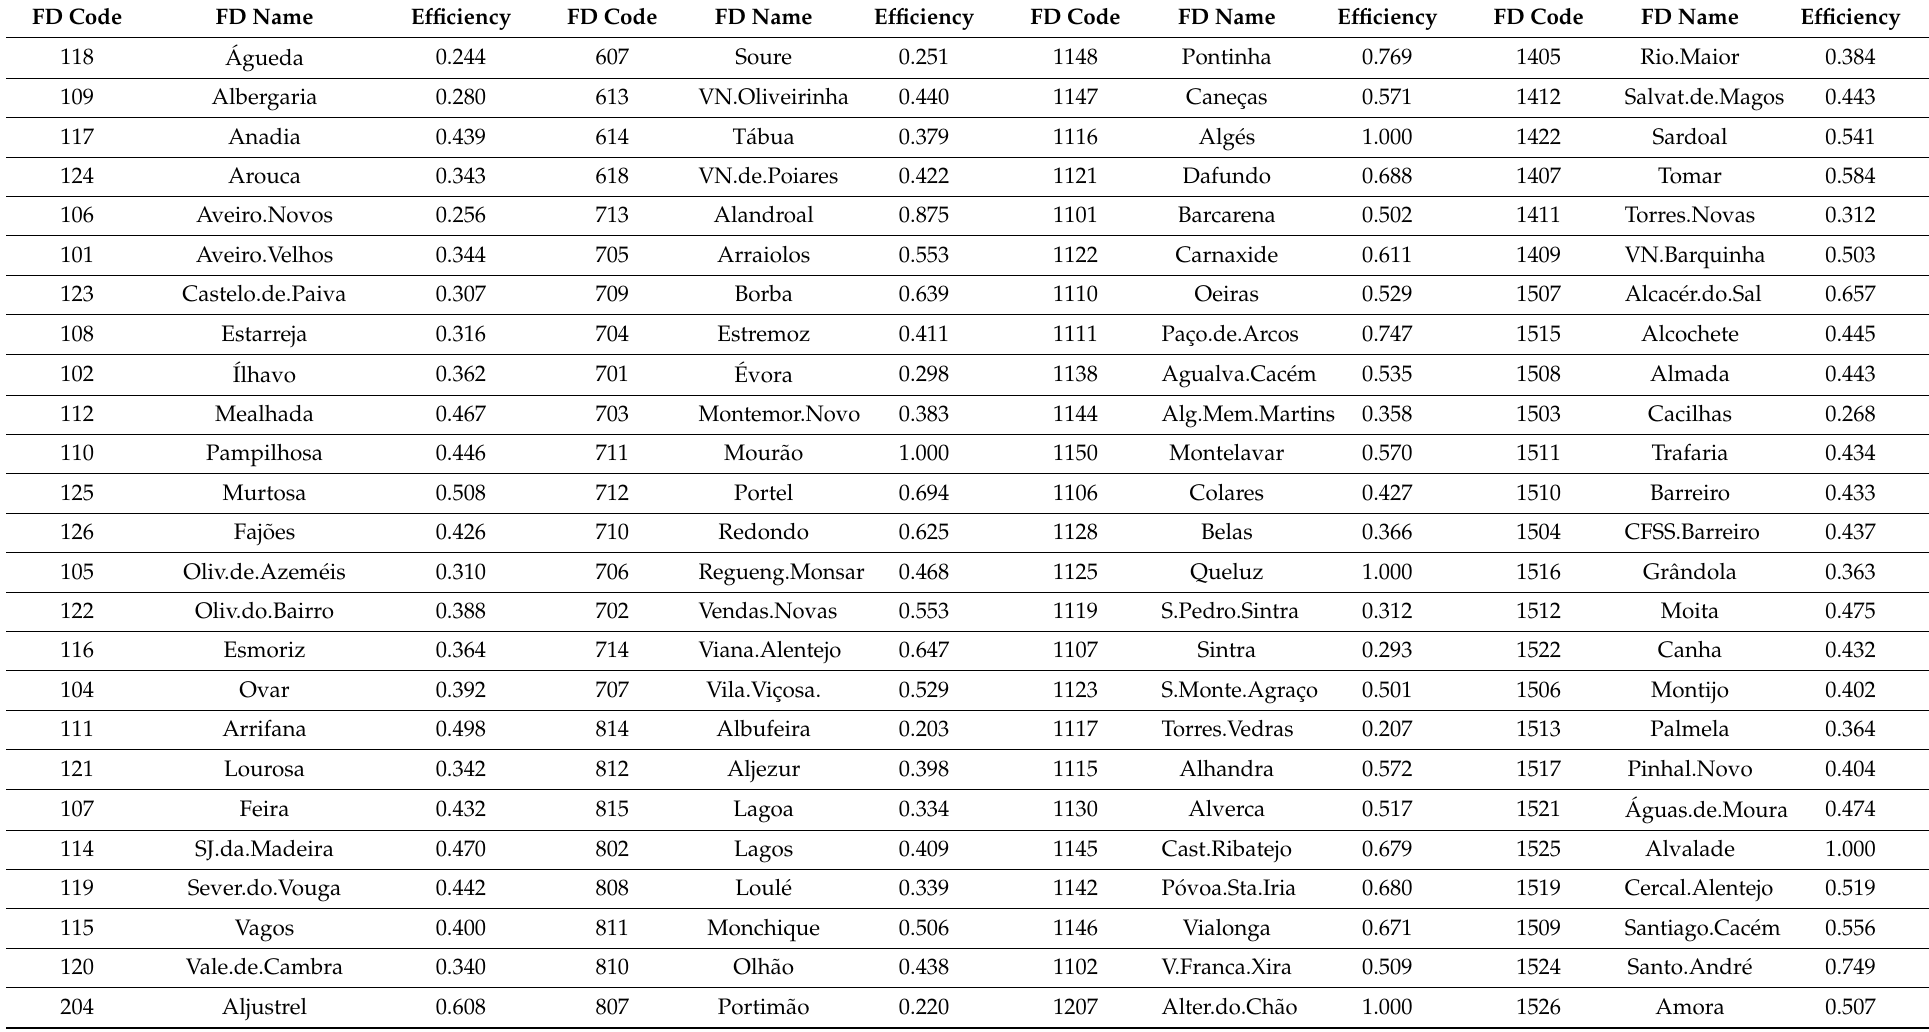
Table 2. Efficiencies of the Portuguese FDs in